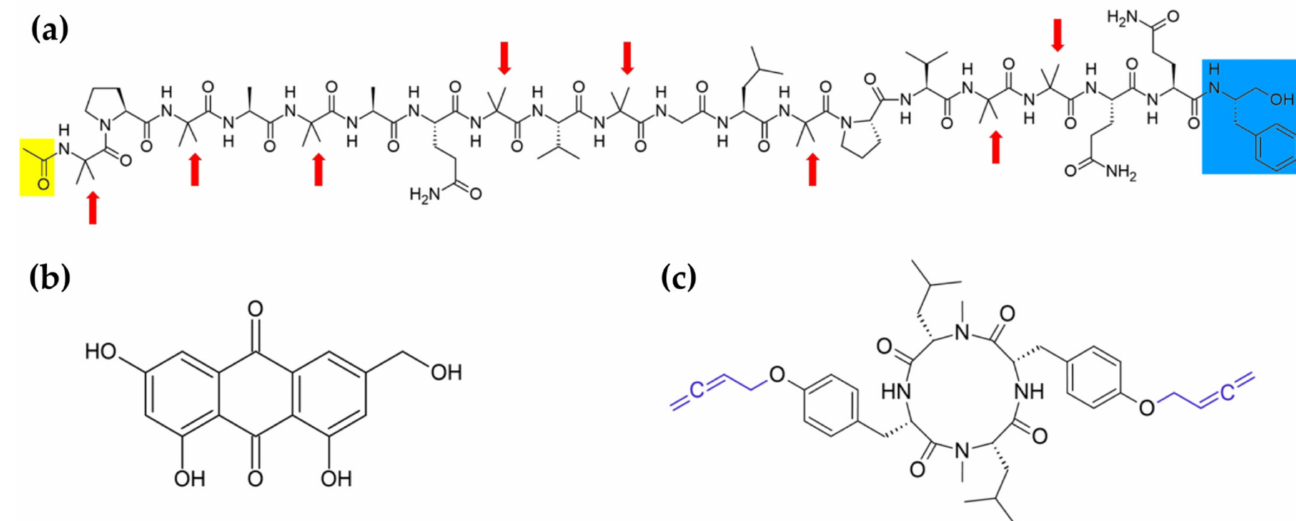
Figure 3. Antimicrobial compounds of the exudates. Molecular structures of: ( a ) peptaibols—on the example of alamethicin F-50 (acetyl group marked in yellow; aminoalcohol marked in blue; red arrows indicate α -aminoisobutyrate residues) [58,60]; ( b ) polyhydroxyanthraquinones— ω -hydroxyemodin [18]; ( c ) pseudoxylallemycins—derivative B (the homoallenyl moieties marked in purple)